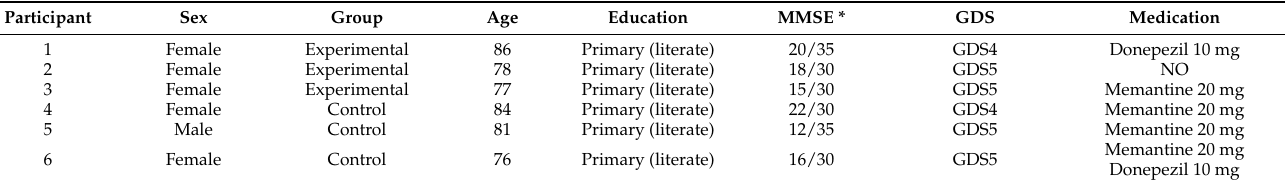
Table 1. Participants’